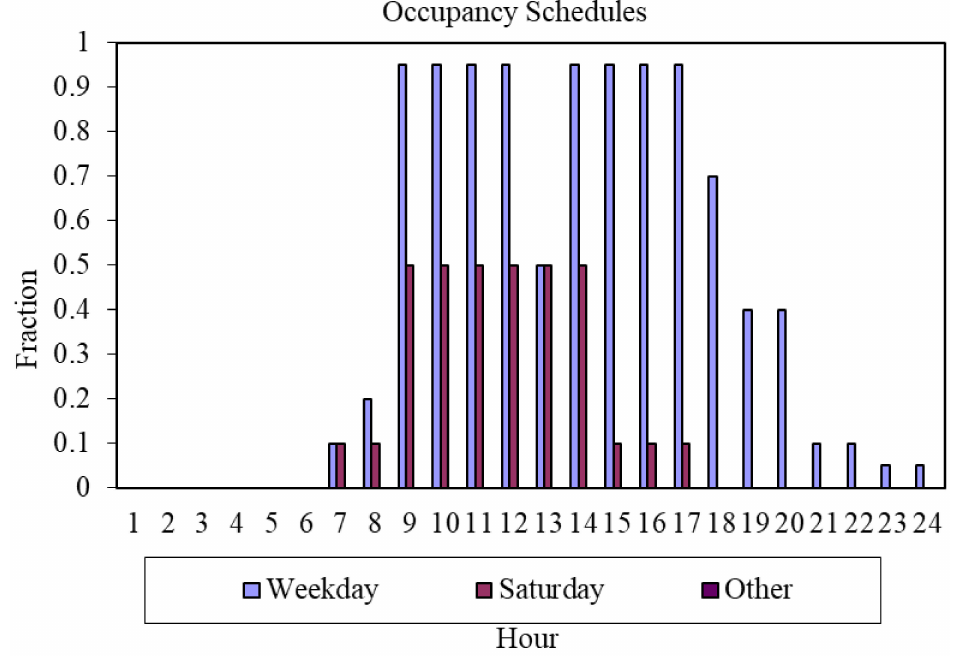
Figure A1. Occupancy schedule of the buildings